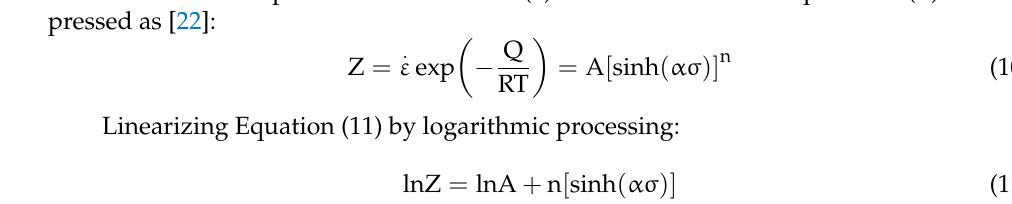
. ε , ( d ) 1000/T- ln[sinh( ασ )]